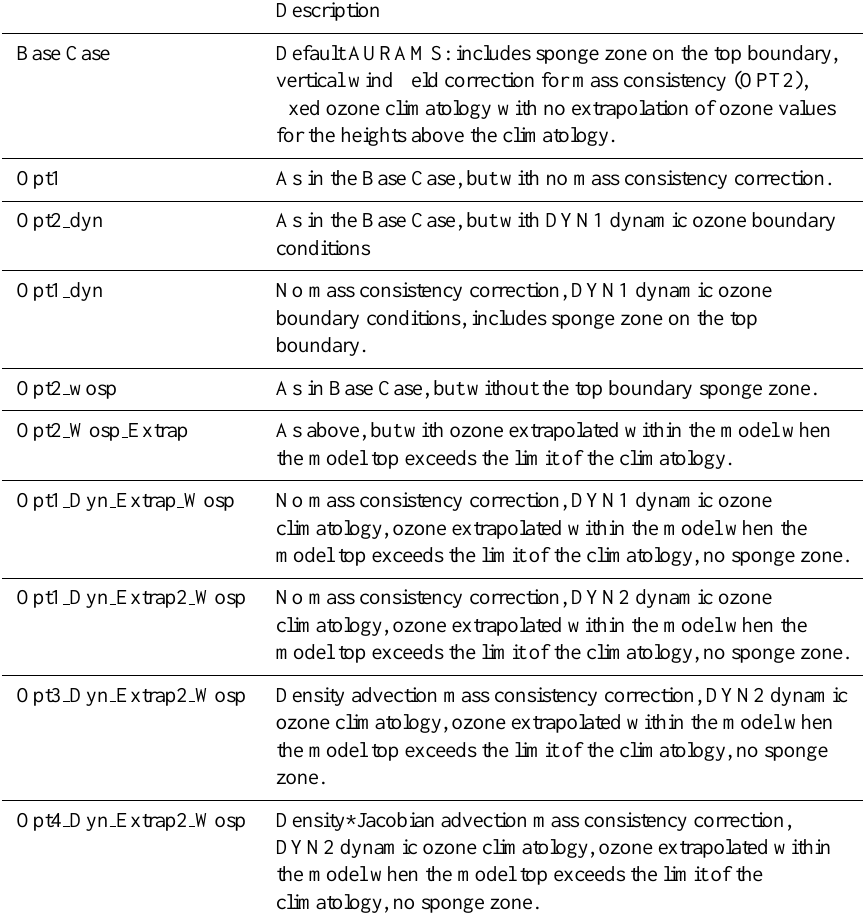
Table 1. Description of boundary condition setup used for simulations in this study.